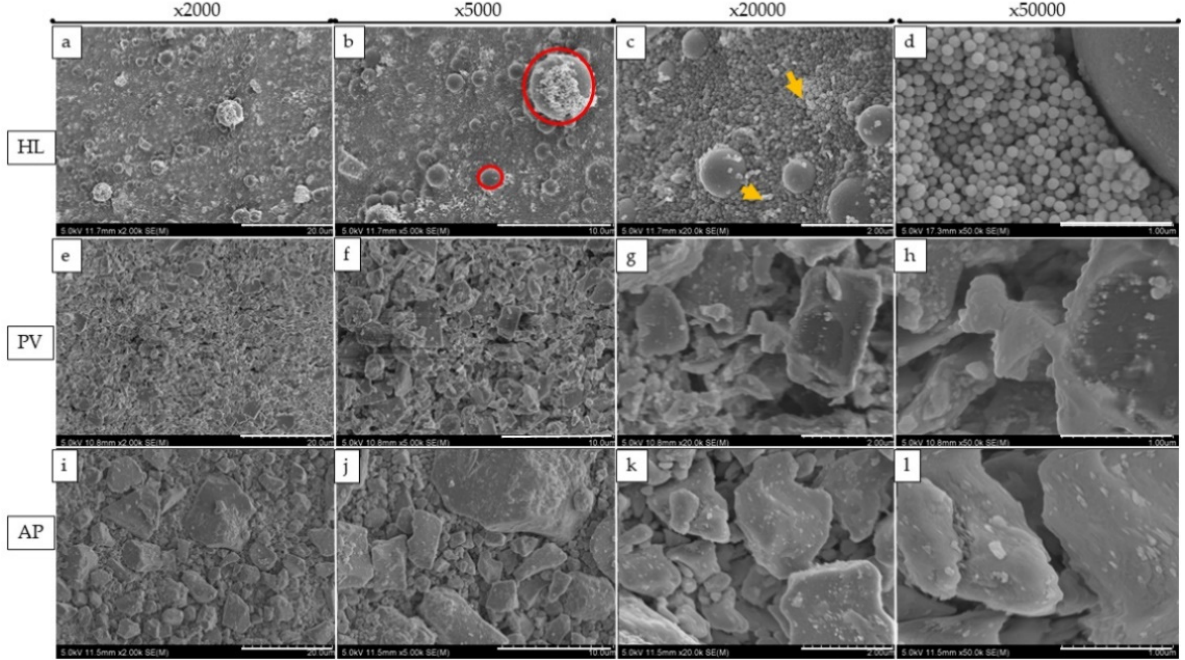
Figure 3. Representation of SEM images of the resin cement fillers. The rows from left to right present images with magnifications of ×2000, ×5000, ×20,000, and ×50,000, respectively; ( a – d ) represent HL; ( e – h ) represent PV; and ( i – l ) represent AP. The red circle represents a cluster with a regular distribution, and the yellow arrow represents nanometer-sized particles with a regular form.